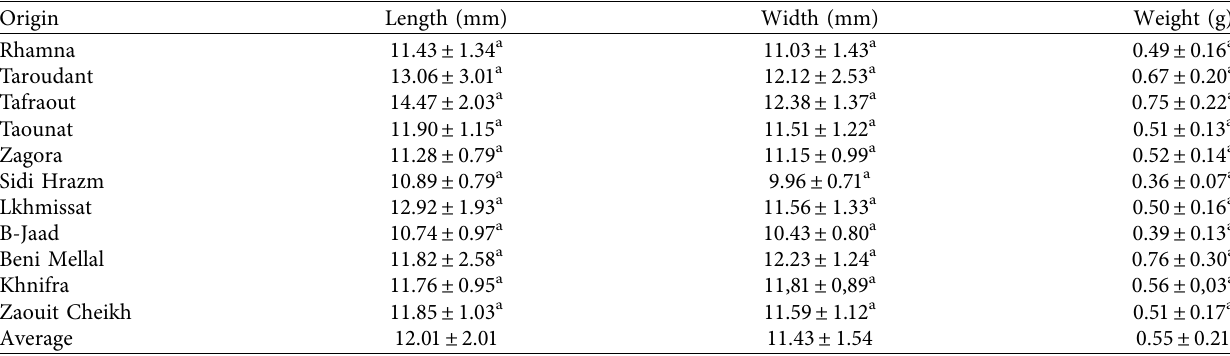
Table 1: Mean values of physical fruit traits of Z . lotus fruits